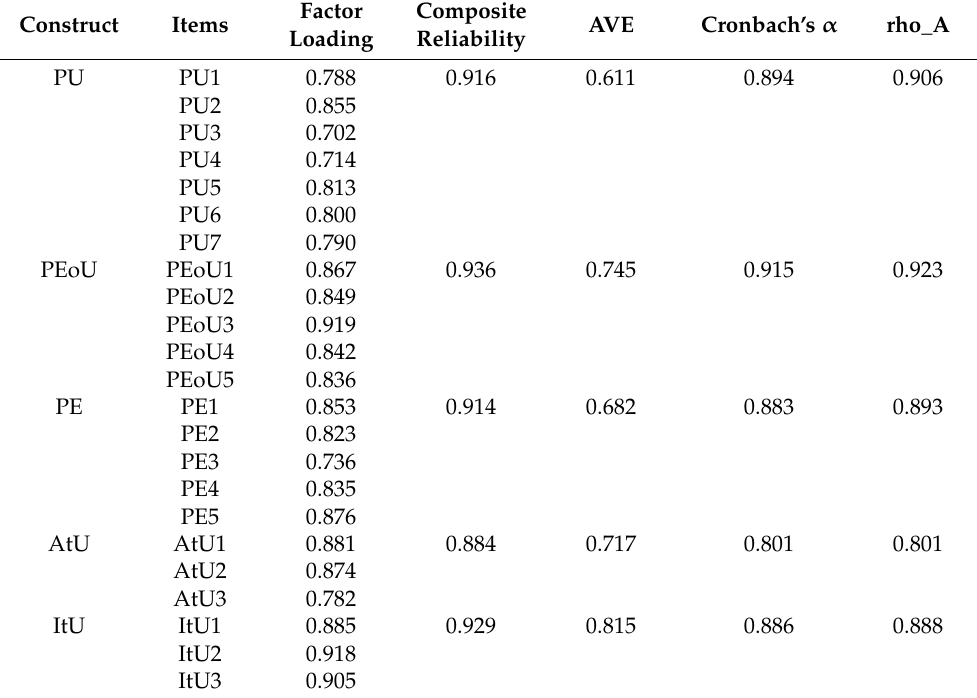
Table 6. Construct reliability and validity. AVE: average variance extracted.